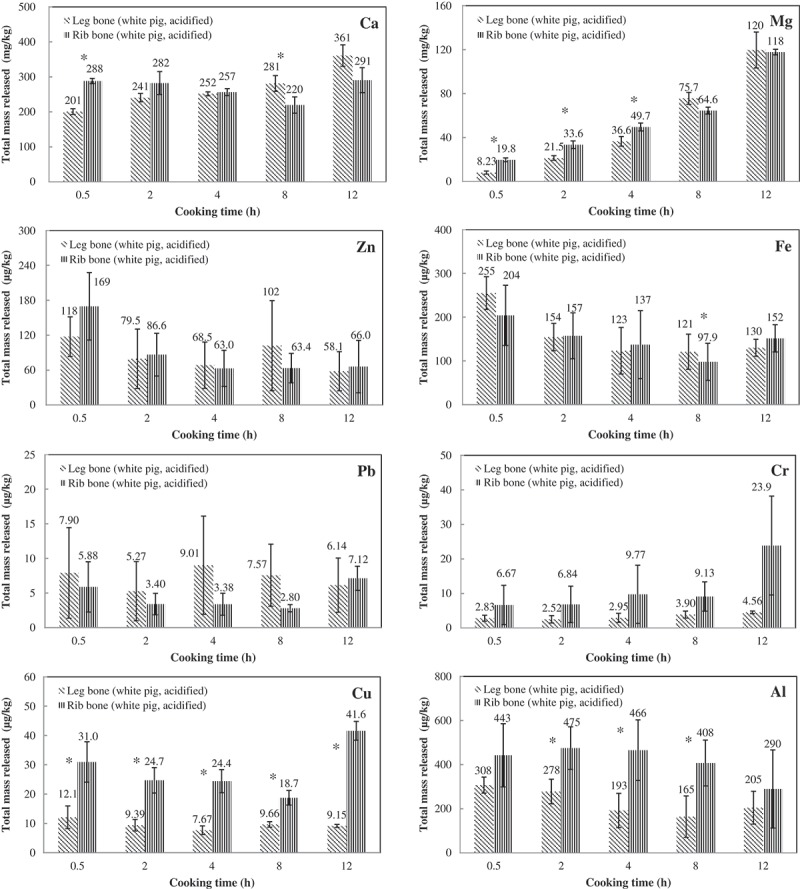
Total amounts extracted for each metal across different sampling time points between the broths made from leg and rib bones. The numbers shown are means of triplicate measurement and error bars are standard deviations. The asterisk indicates statistically significant difference (p < 0.05, paired t-test) between the two broths.